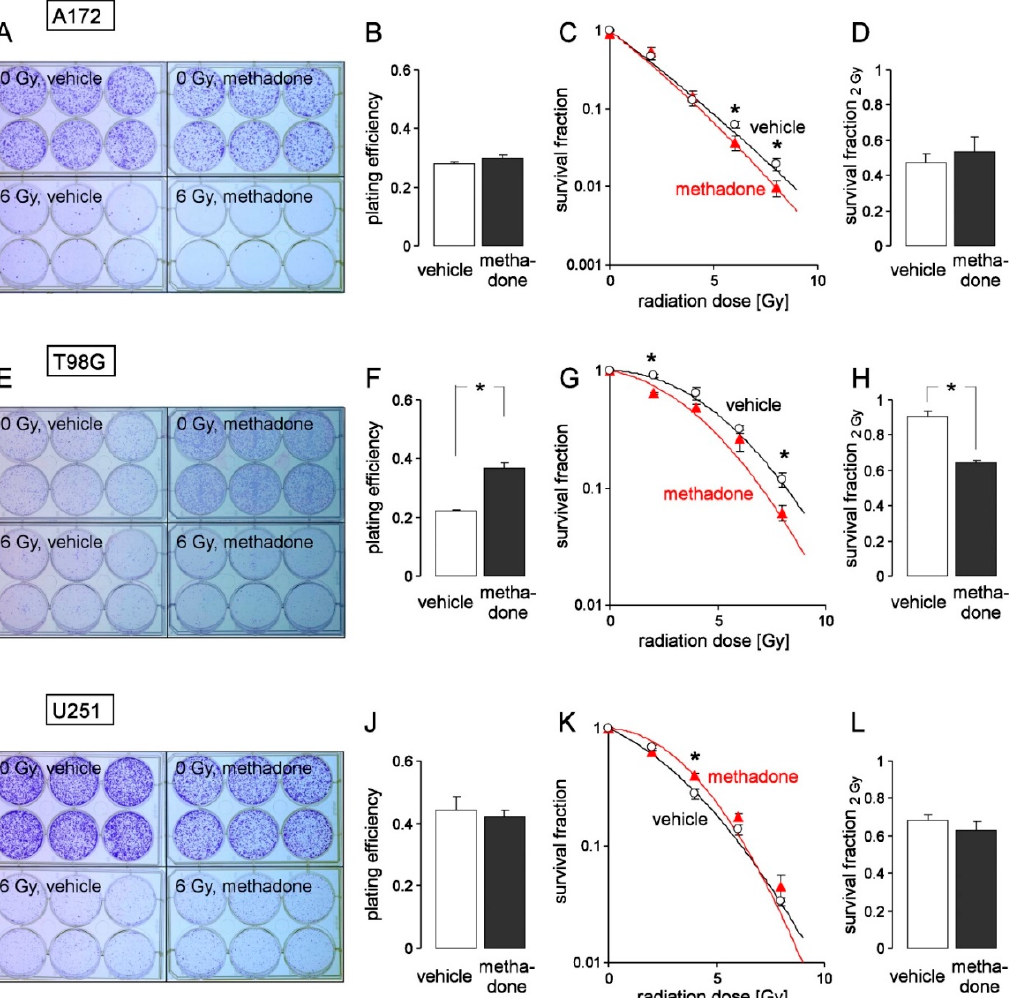
Figure 4. Heterogeneous effects of high-dose methadone (20 µM) on clonogenic survival of irradiated (0–8 Gy) human A172 ( A – D ), T98G ( E – H ) an U251 ( I – L ) glioblastoma cells. ( A , E , I ) Coomassie blue-stained colonies regrown from single 0 Gy (upper row)- and 6 Gy (lower row)-irradiated A172 ( A ), T98G ( E ), and U251 ( I ) glioblastoma cells pre- (1 h) and post-incubated (24 h) with either 0 µM (vehicle, ethanol, left) or 20 µM (right) methadone. ( B, F, J) Mean (± SE, n = 11–12) plating efficiency of A172 ( B ), T98G ( F ), and U251 ( J ) glioblastoma cells incubated (24 h) with either 0 µM (vehicle, open bar) or 20 µM (closed bar) methadone. ( C , D , G , H , K , L ) Mean (± SE, n = 11–12) survival fraction of irradiated (0, 2, 4, 6, and 8 Gy in ( C , G , K ) and 2 Gy in ( D , H , L )) A172 ( C , D ), T98G ( G , H ), and U251 ( K , L ) cells irradiated and pre- (1 h) as well as post-incubated (24 h) with either 0 µM (vehicle, open circles and open bars) or 20 µM (red triangles and closed bars) methadone. * indicates p ≤ 0.05, two- tailed (Welch-corrected) t -test. For delayed plating colony formation, cells were irradiated (0, 2, 4, 6, 8 Gy) and post-incubated for 24 h in the absence (vehicle) or presence of methadone (20 µM). Then, cells were replated in methadone-free medium and grown for a further two weeks. Thereafter, colonies were defined as cell clusters of ≥ 50 cells and colony numbers were counted. Plating efficiency (PE) was defined by the ratio between counted colonies (N) and plated cells (n) under control conditions (PE = N/n). The survival fraction (SF) was calculated by normalizing in both arms (methadone and vehicle control) separately the plating efficiency after irradiation (PE xGy ) to that of the corresponding unirradiated control (PE 0Gy ) by the formula SF = PE xGy /PE 0Gy . SFs were fitted by the use of the linear quadratic equation (SF = e -( α· D + β· D^2) with D = radiation dose and α and β cell-specific constants).